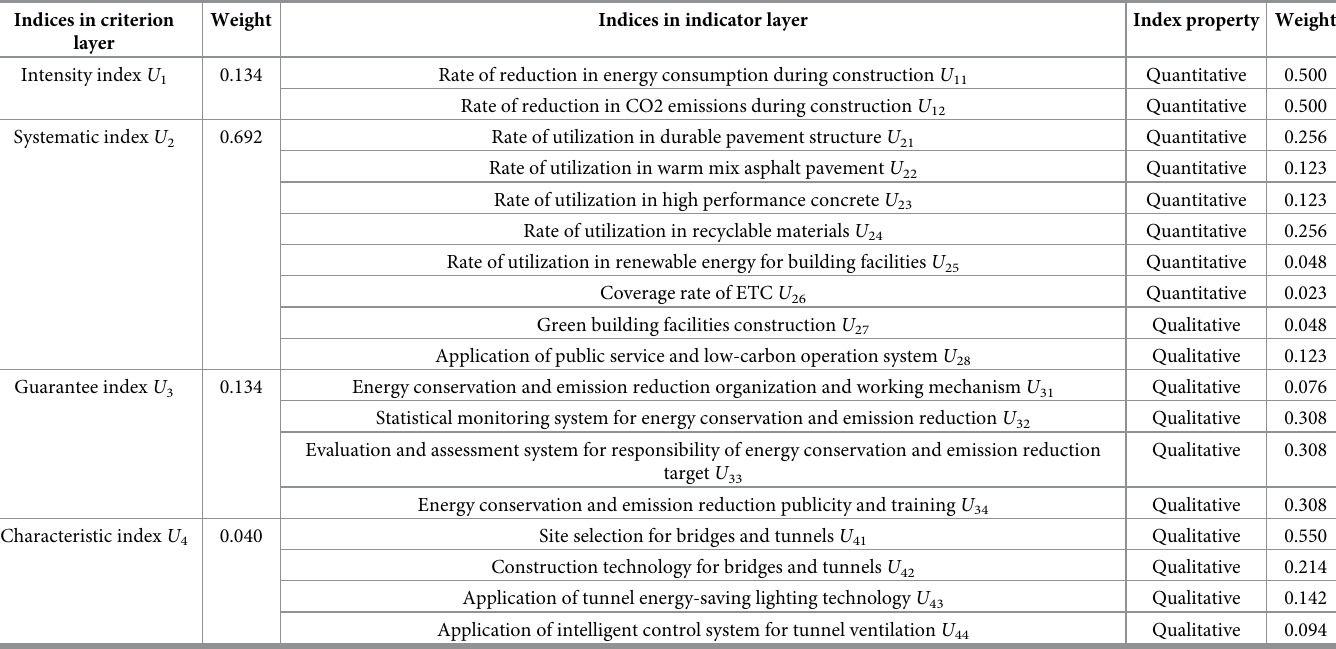
Table 8. The weights of green and low-carbon expressway construction evaluation index system of Huangling-Yan’an Expressway. Indices in criterion layer